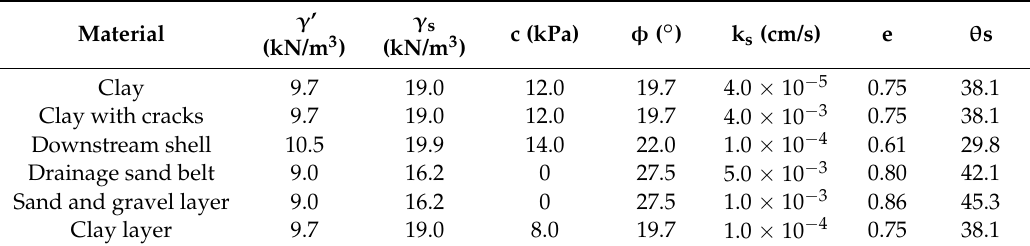
Figure 10. FEM for seepage and stability calculation. Table 1. Physical and mechanical parameters of the dam materials. In this table, γ ’ is buoyant unit weight, γ s is wet unit weight, c is cohesive force, φ is internal friction angle, k s is saturated permeability coefficient, e is void ratio, and θ s is saturated water content.